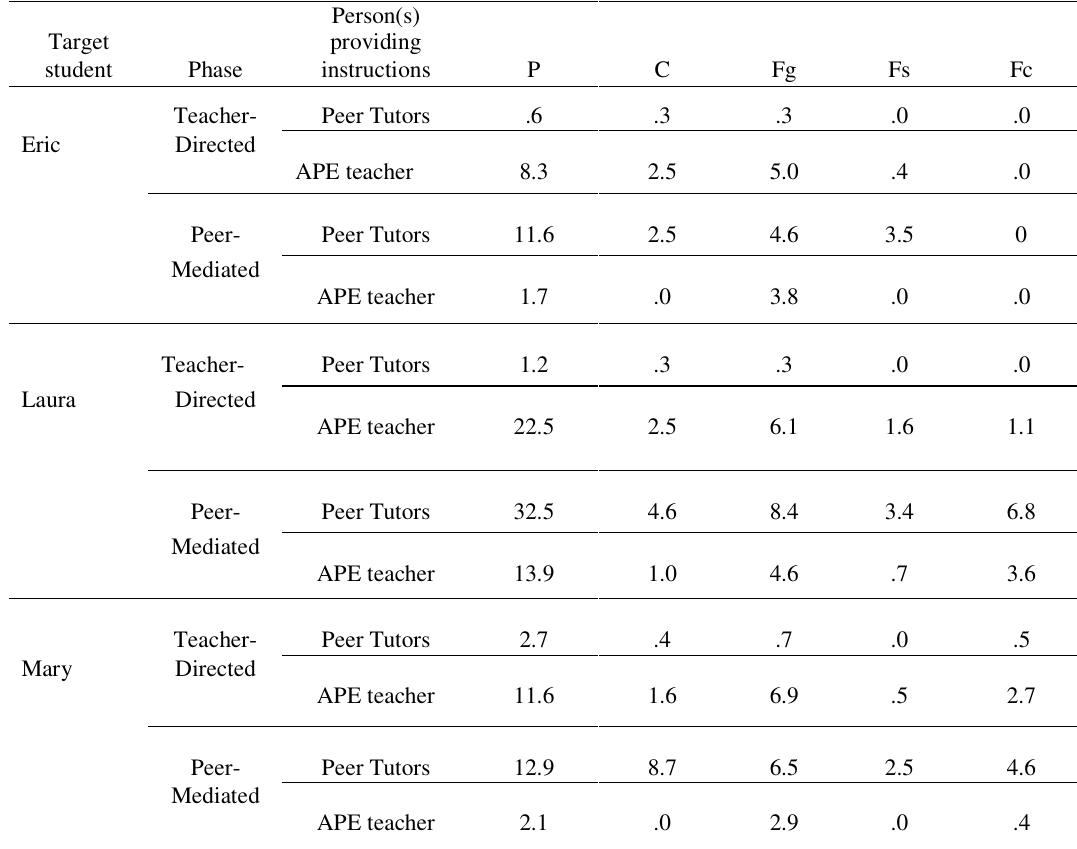
Mean Percentage of Intervals in Instructional Interaction Behaviors Demonstrated by Peer Tutors across Teacher-Directed and Peer-Mediated